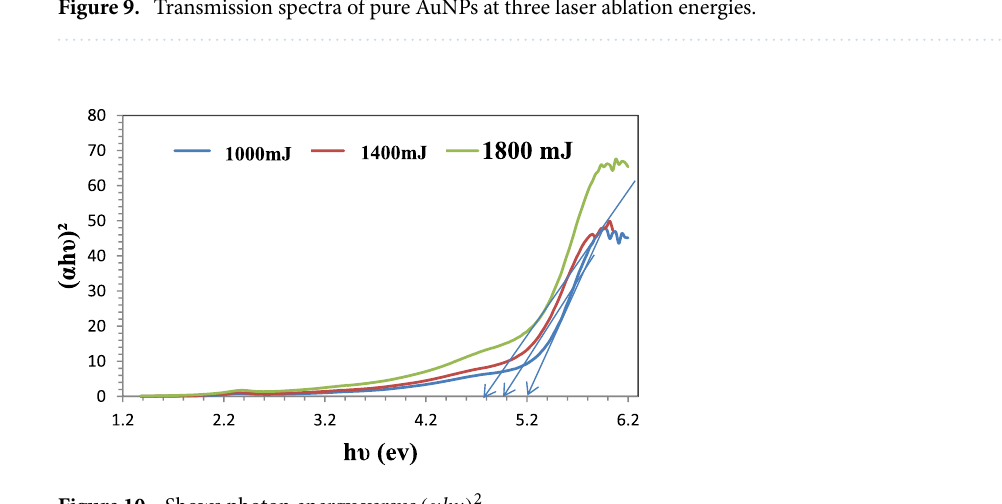
Figure 10. Shows photon energy versus (α h ν) 2